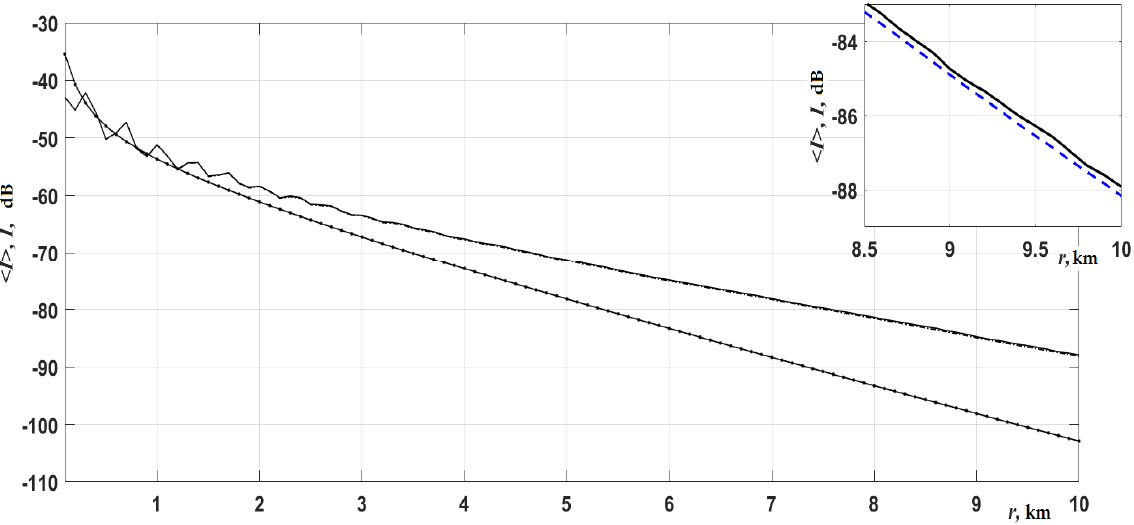
Figure 4. Curves of the average intensity are similar to Figure 3. For a distance of 8.5–10 km, two upper curves are shown in the inset in the upper right corner of the figure. The lower marker curve is a deterministic solution. N = 10 3 . H = 40 m, z = z 0 = 16 m.